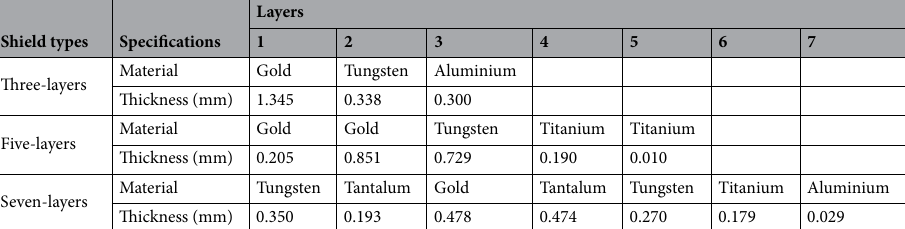
Table 2. Results of Genetic Algorithm for three, five, and seven-layer